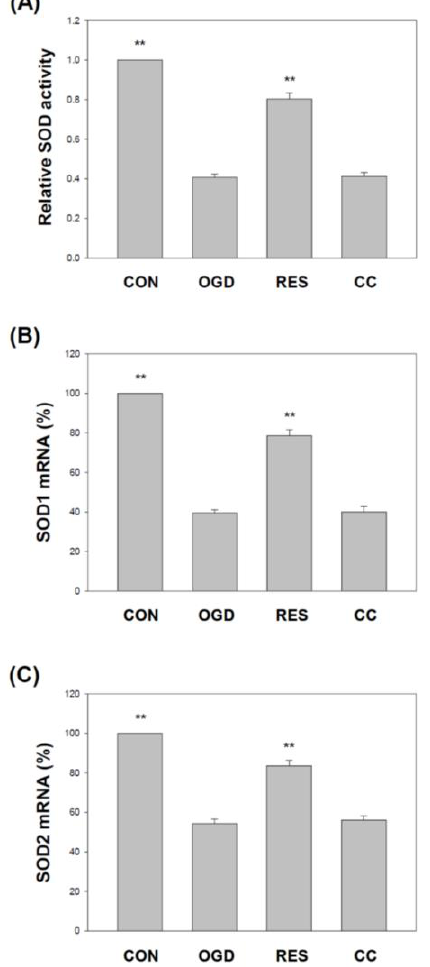
Figure 9. Resveratrol rescues SOD activity and gene expression by OGD in 3D scaffolds. The cell experiments under the scaffolds were divided into four groups, as described in Figure 1 and the methods section. SOD activity was detected by a SOD activity assay ( A ). qPCR was used to analyze each treatment group’s SOD1 ( B ) and SOD2 ( C ) mRNA levels. Values are expressed as percentages of the indicated level in CON and are presented as the mean ± SEM values from three independent experiments. Specific comparison to the indicated SH-SY5Y cells with OGD ** p < 0.001 vs. cells with